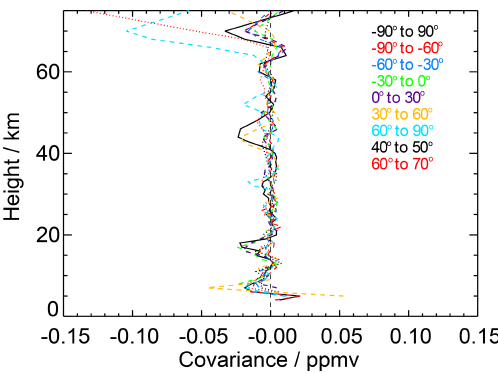
Figure 1. Covariance of the averaging kernel and ozone mixing ra- tio for various latitude bands. The solid black line refers to global data. The dashed lines refer to 30 ◦ latitude bands, and the dotted lines refer to 10 ◦ latitude bands.